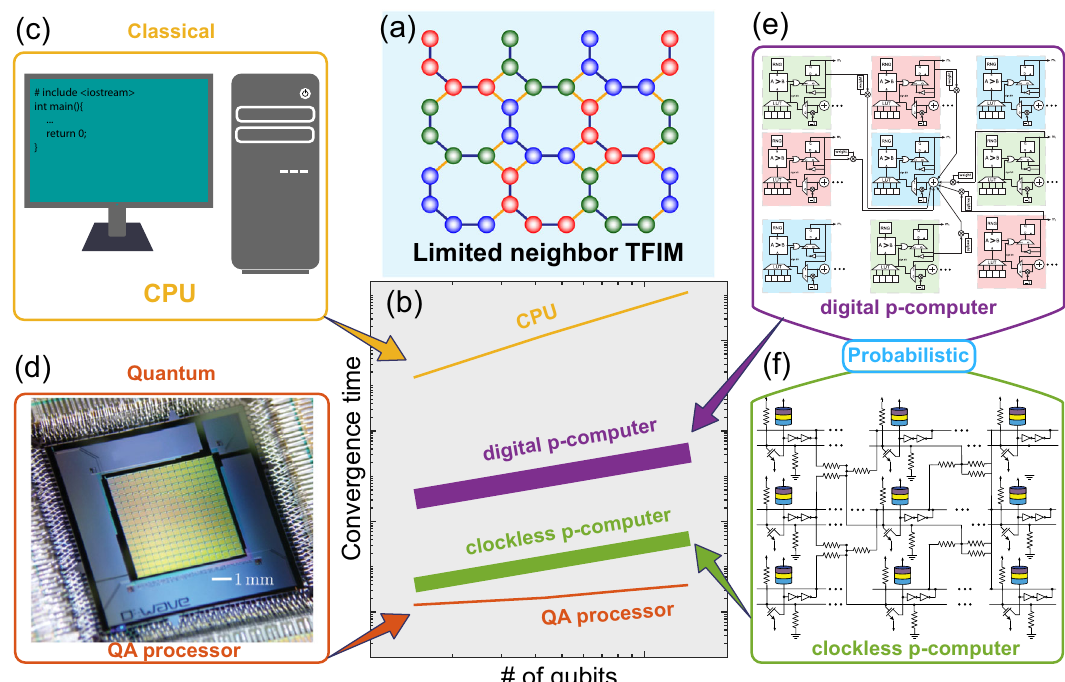
Fig. 1 Performance of specially designed p-computers, digital and clockless, relative to a CPU and a quantum annealer. a We use an example problem consisting of a lattice of qubits described by a transverse fi eld Ising model. We simulate it classically using the Suzuki-Trotter transformation and calculate a pre-de fi ned order parameter using three different types of hardware whose relative convergence times are sketched in b . The variations in performances due to variations in implementation technologies are indicated with thick lines. The four types of hardware are also shown schematically — c a von Neumann machine (CPU) — which simulates the problem by breaking down the problem into a series of instructions and executing them sequentially one after another, d a physical quantum annealing processor (QA) that maps the problem onto an interconnected network of rf-SQUIDs (radio-frequency- superconducting quantum interference devices) emulating qubits and rf-couplers coupling those qubits e a digital p-computer built using fi eld programmable gate array (FPGA) to lay out a spatial network of interconnected probabilistic p-bits and f a clockless p-computer constructed by interconnecting a network of p-bits through resistors. The quantum annealing processor image has been taken from Harris et al. Phase transitions in a programmable quantum spin glass simulator. Science 361, 162 – 165 (2018). Reprinted with permission from